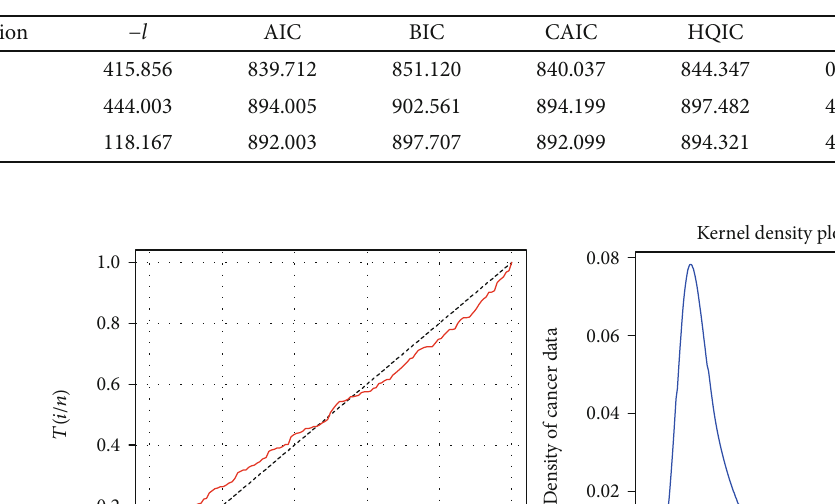
Table 6: Selection criterion statistics for cancer data.